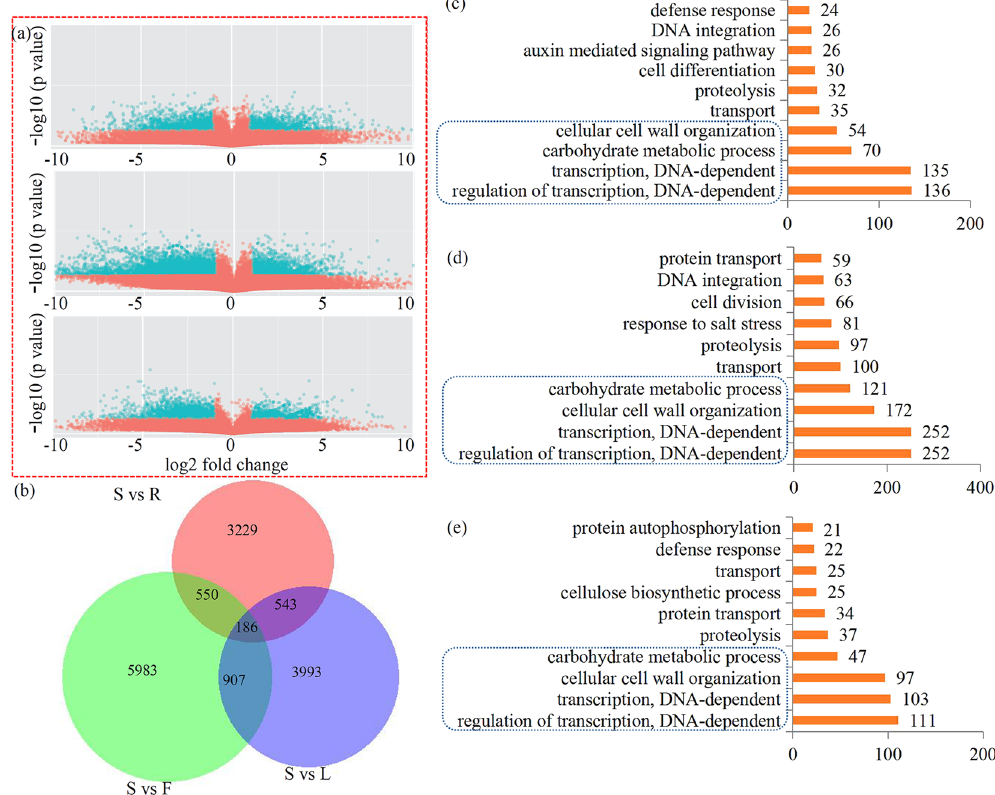
Figure 3. Overview of the differentially expressed unigenes (DEGs) among four different organs in D. officinale . ( a ) Volcanoplots of the DEGs in different comparisons, including S vs R, S vs F and S vs L. ( b ) VennDiagrams of the DEGs in different comparisons. Gene Ontology (GO) classification of DEGs in the S vs R comparison ( c ), S vs F comparison ( d ) and S vs L comparison ( e